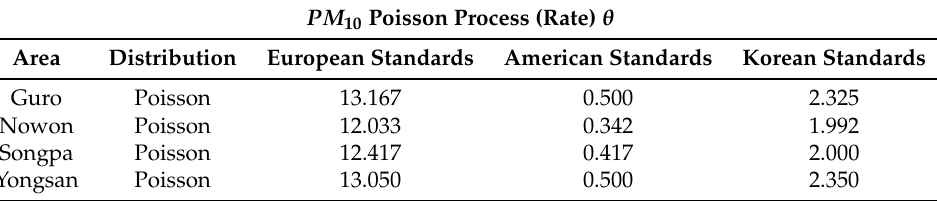
Table 8. PM 10 Poisson